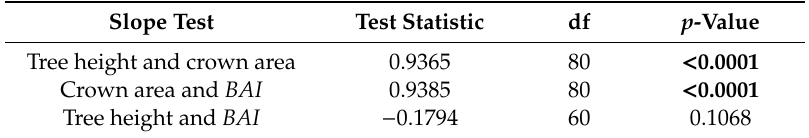
Figure 6. Allometric relationships ( n = 82) between ( a ) tree height and crown area, ( b ) crown area and BAI , and ( c ) tree height and BAI , using SMA regression. Table 4. Slope tests of the SMA regressions shown in Figure